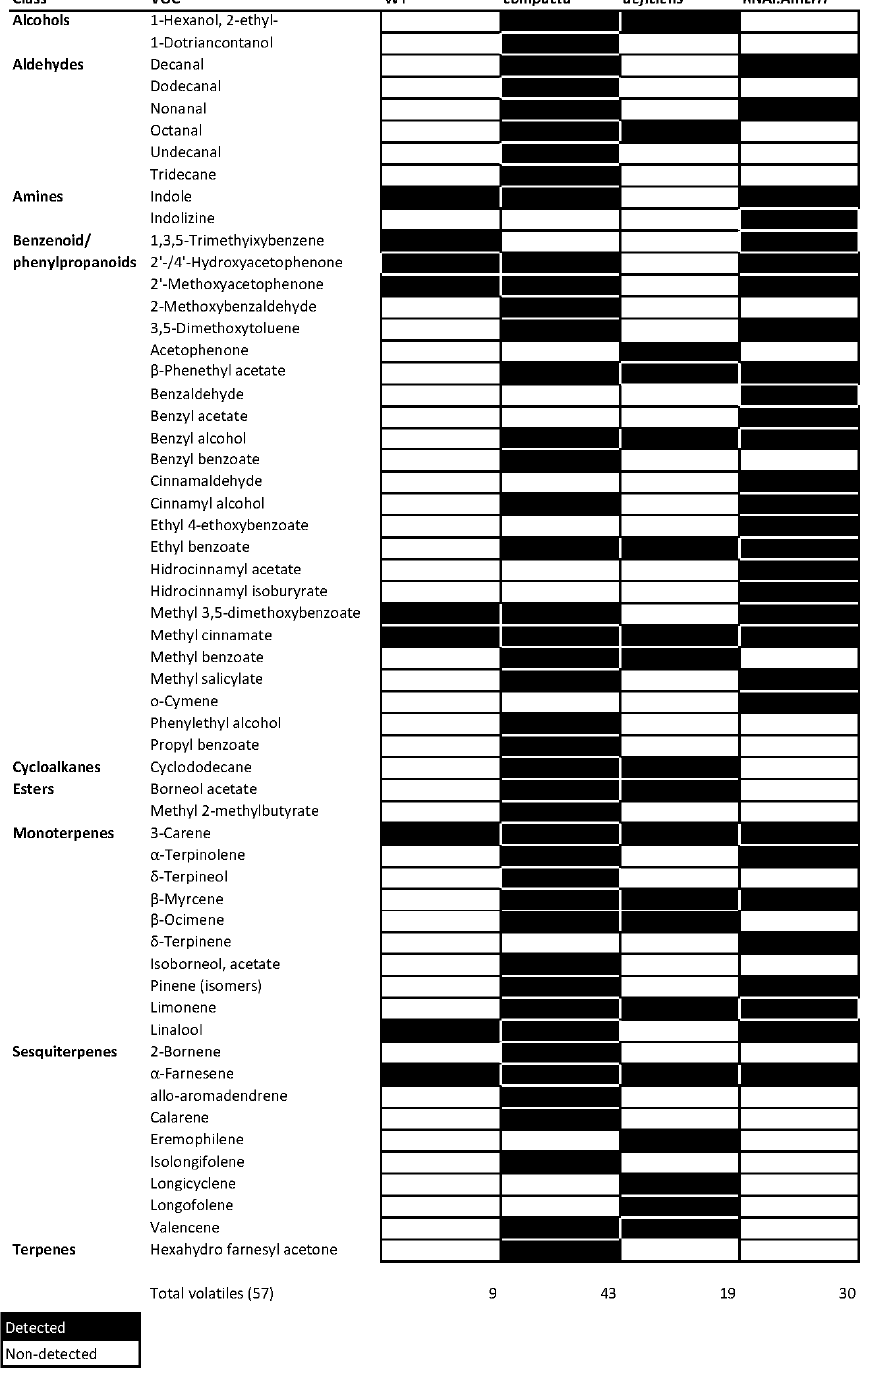
Figure 4. Heat map of non-constitutive by frequency scent profiles of wild-type snapdragon (Sippe 50, WT), the mutants compacta and deficiens-nicotianoides and the transgenic line RNAi:AmLHY . We set minQuality to 80% (NormalizeWithinFiles function). Non-constitutive profile comprises those compounds that present in 99% or less of analyzed samples. Volatile compounds are clustered by class. Black and white colors indicate a detected and a non-detected compound, respectively. Total volatiles, indicates the number of detected volatiles among snapdragon genotypes.